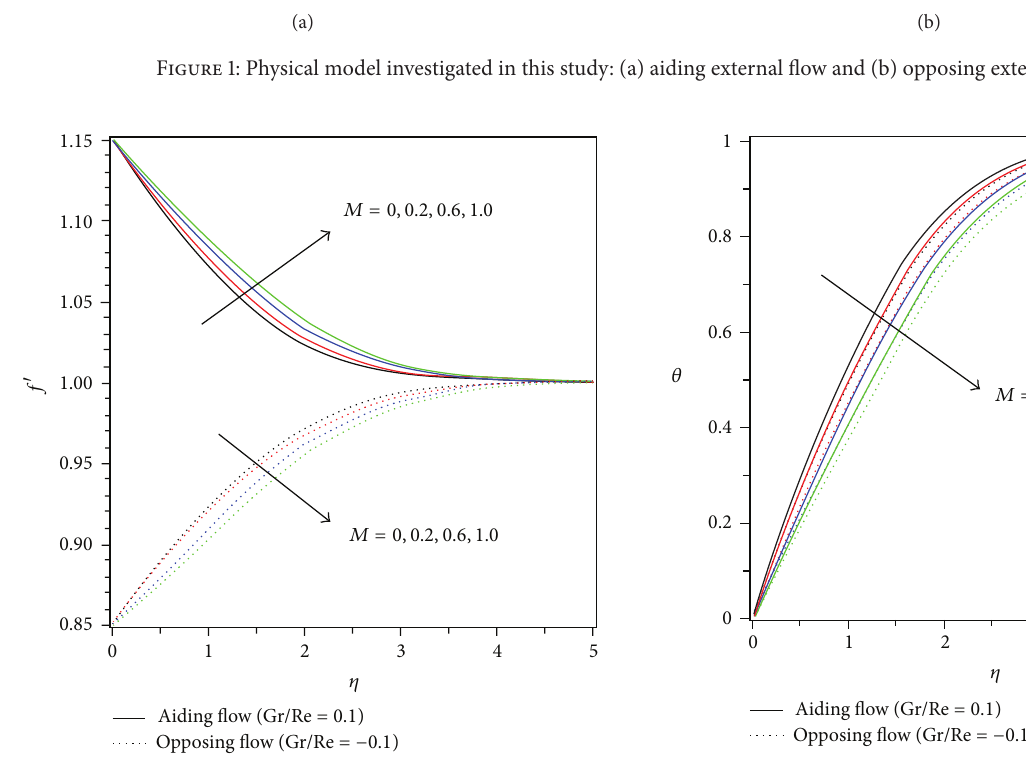
Figure3:Temperatureprofileforbothaidingandopposingexternal flows for different values of 𝑀, 𝑁 = 0.5 , Df = 0.02 , Sr = 0.2 , and Le = 1.0